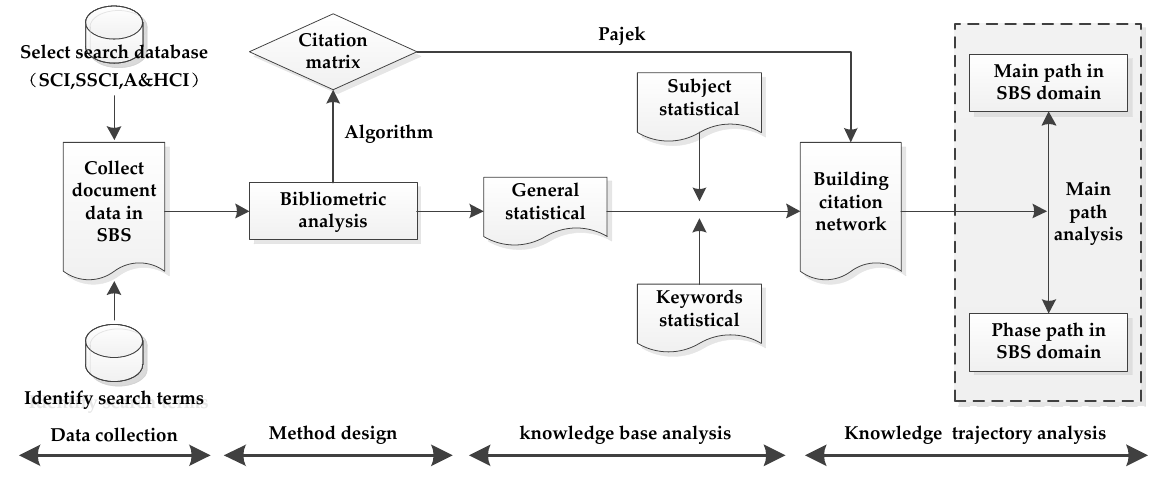
Figure 2. Research framework in SBS domain.